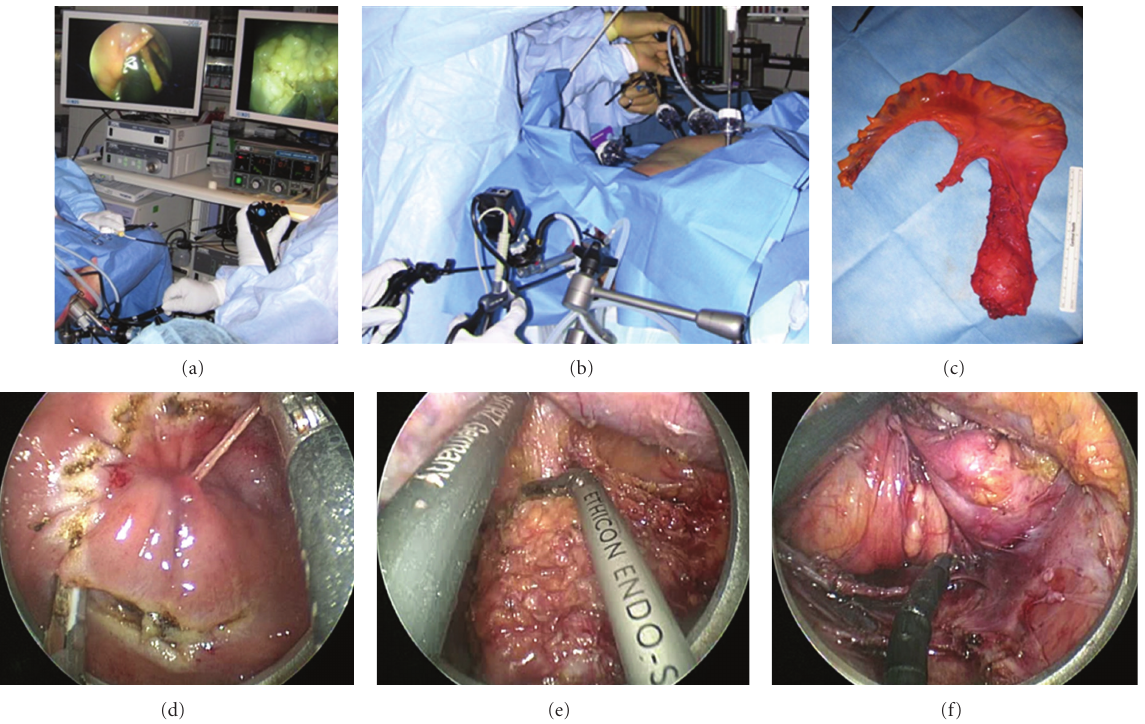
Figure 2: (a) Set up for pure NOTES transanal rectosigmoid resection via TEM using standard instruments and endoscopic tools in cadavers using a colonoscope for visualization. (b) Set up for transanal NOTES rectosigmoid resection with laparoscopic assistance in cadavers. (c) Transanal circumferential and full-thickness rectal dissection through the TEM platform, starting just below the purse-string suture, in a female patient with an upper rectal cancer. (d) Transanal posterior mesorectal dissection using laparoscopic instruments through the TEM platform in a female patient. (e) Transanal mobilization of the anterior rectal wall and peritoneal entry through the TEM platform in a female patient. (f) Intact rectosigmoid specimen and mesorectum following transanal NOTES